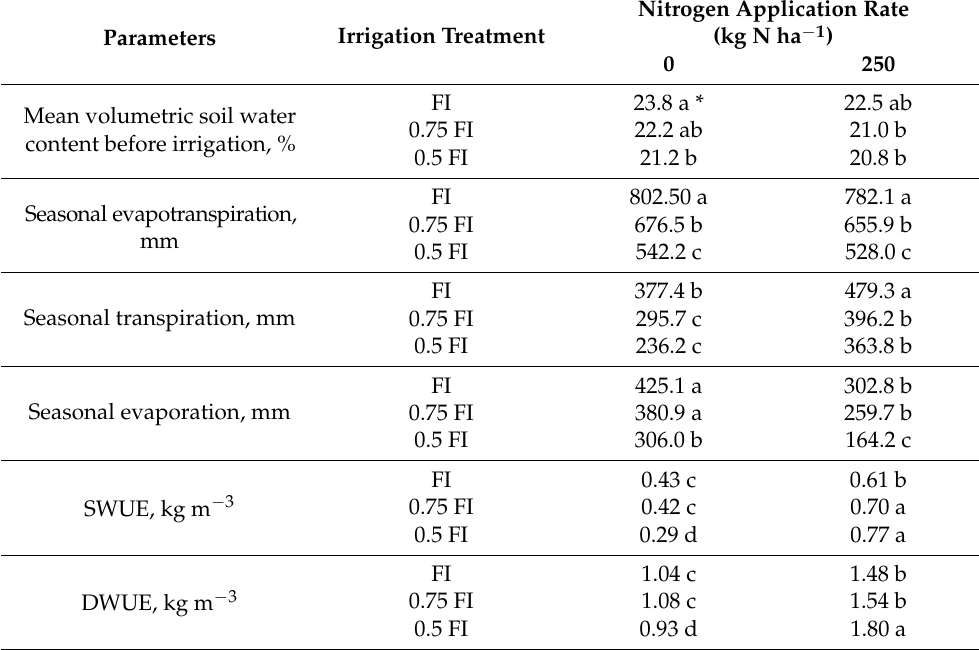
Table 1. Seasonal mean soil water content, seasonal evapotranspiration, evaporation, transpiration, seed, and total dry matter water use efficiencies (SWUE, DWUE) for two nitrogen application rates and irrigation regimes averaged in two growing